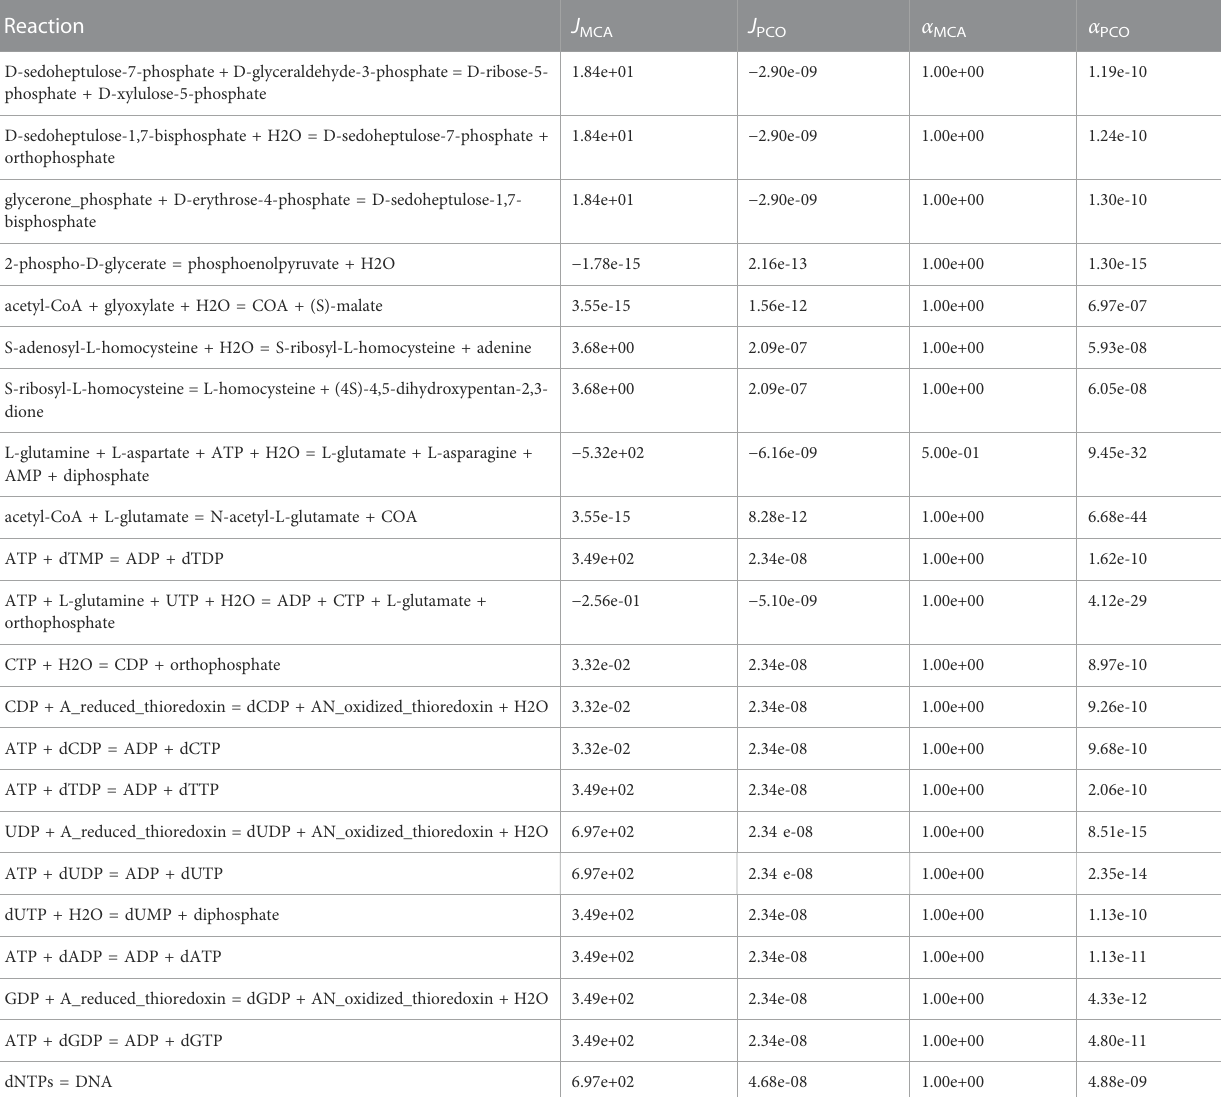
TABLE 4 Reactions regulated in the PCO method but not in the MCA method and that have insigni fi cant reaction fl ux in the PCO method. Presumably these reactions are shut down to redirect mass fl ow to the growth reactions. Reaction J